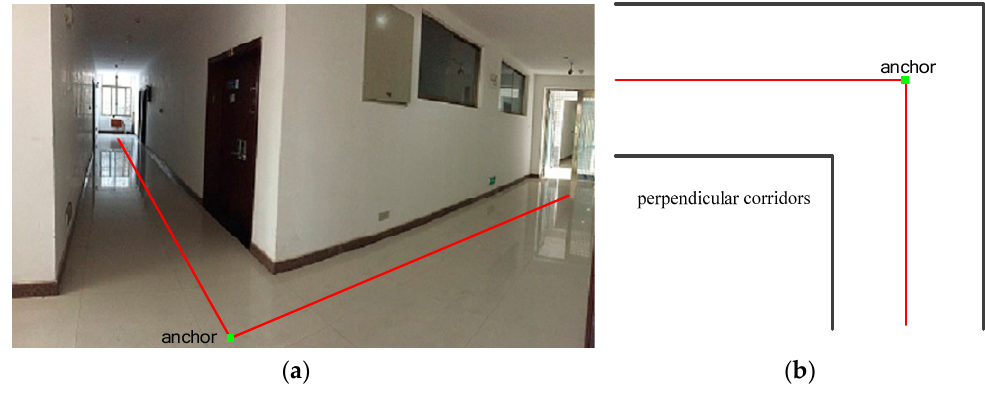
Figure 2. Anchor definition. ( a ) The real-scenario Perpendicular Intersectant Corridors (PIC) from a typical office building; ( b ) the floorplan of a PIC. typical office building; ( b ) the floorplan of a